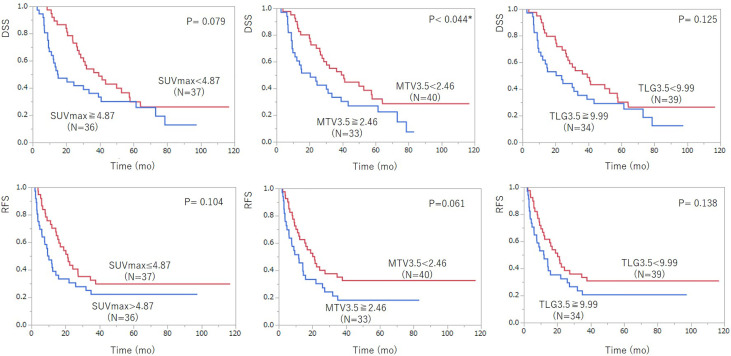
Kaplan–Meier survival analysis of 18F-FDG PET/CT parameters including SUVmax, MTV3.5, and TLG3.5 according to disease-specific survival (DSS) (top row) and recurrent-free survival (RFS) after pancreatic cancer surgery (bottom row). Among the 18F-FDG PET/CT parameters, MTV3.5 showed statistically significant prediction ability for DSS and had a tendency for RFS. TLG3.5 was not a significant prognostic indicator for DSS and RFS.